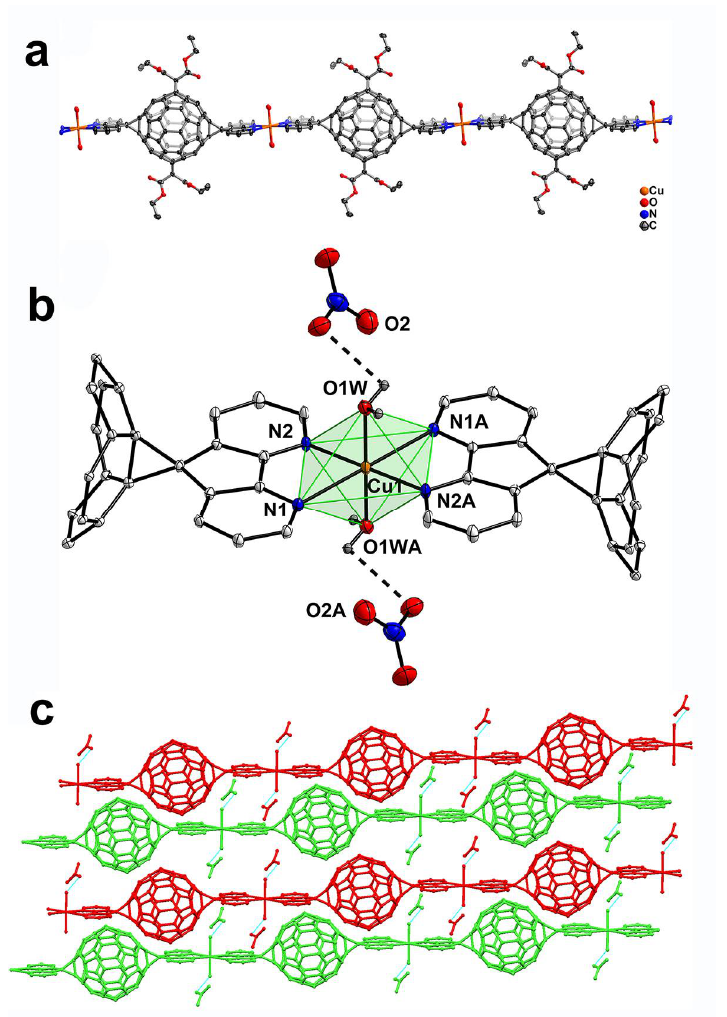
Figure 4. ( a ) 1D linear chain structure of Cu( L1 )(H 2 O) 2 (NO 3 ) 2 ( 3 ), front and back malonate addends and all hydrogen atoms have been omitted for clarity; ( b ) the local environment of Cu center; ( c ) packing structure of 3 , hydrogen atoms and malonate addends have been omitted for clarity.